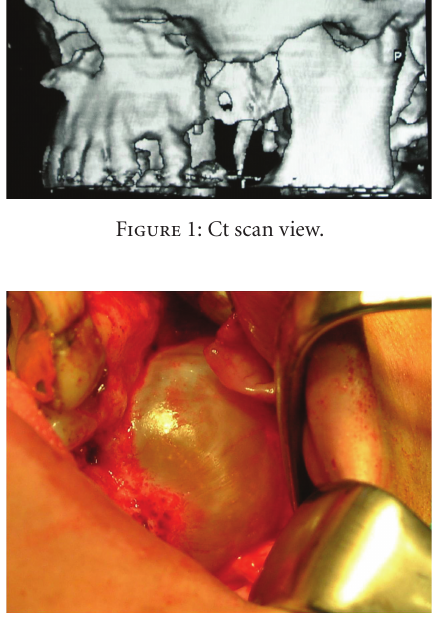
Figure 2: Intraoral view of cyst.